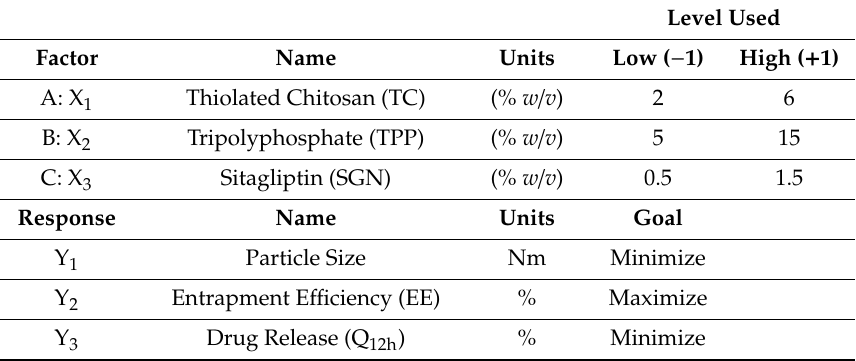
Table 1. The formulation factors and responses of Box-Behnken design for sitagliptin thiolated chitosan (SGN–TC) nanoparticles.